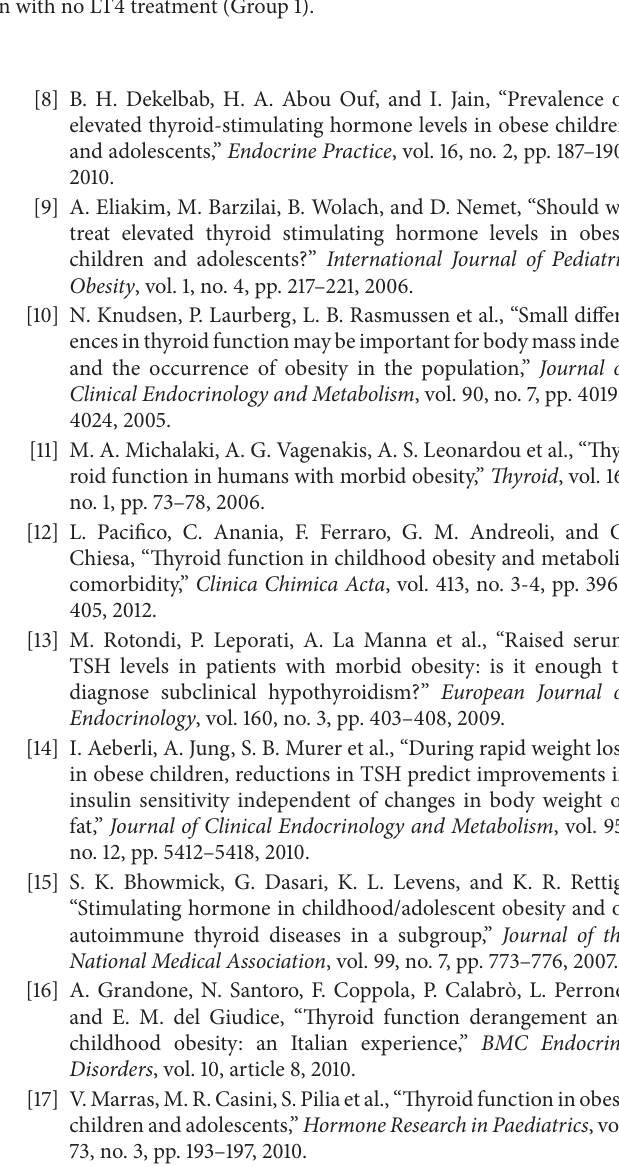
Figure 4: Relationship of change in TSH level (delta TSH) with respect to the nutritional status improvement (delta BMI 𝑧 -score) (a) and with respect to the initial TSH level (b), in the group of obese children with no LT4 treatment (Group 1).